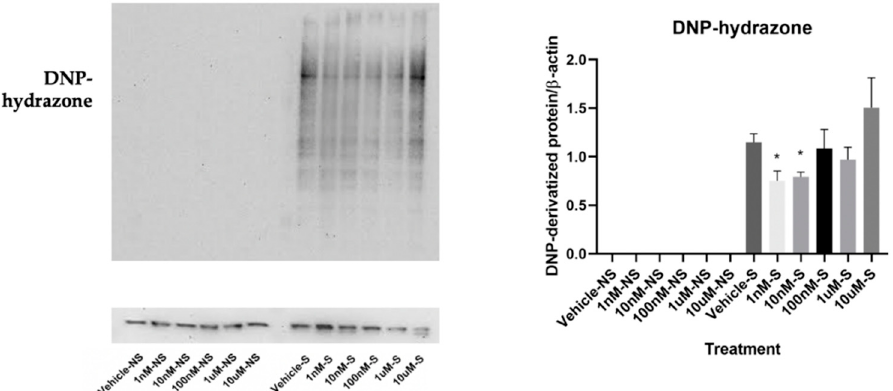
Figure 2. Effects of lycopene treatment at 1 nM, 10 nM, 100 nM, 1 μ M, and 10 μ M for 24 h on oxidative stress. Graphic representation of fold changes in the carbonyl groups that were introduced to protein side chains, quantified by using OxyBlot analysis. Three replicates were used for statistical analysis. Values are means ± SEMs. S—cells exposed to smoke; NS—cells not exposed to smoke; * indicates significance at p < 0.05 compared with cells exposed to smoke treated with vehicle.